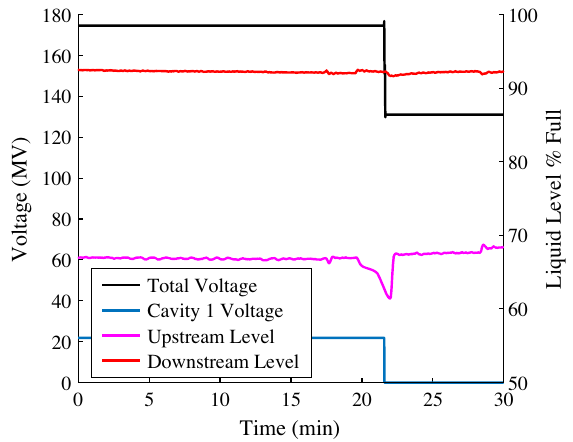
FIG. 17. Data showing that lowering the gradient in cavities 1 and 2 recovered the liquid level drop in the upstream